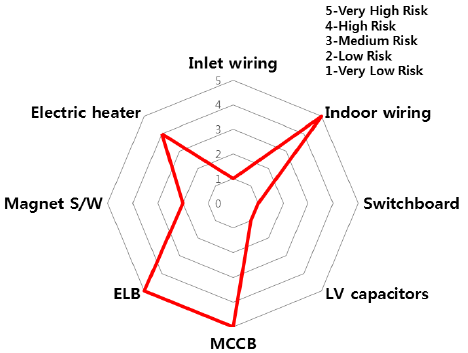
Figure 18. The risk rating for low voltage equipment by device. Table 9. The number of accidents and risk rating for high voltage equipment.